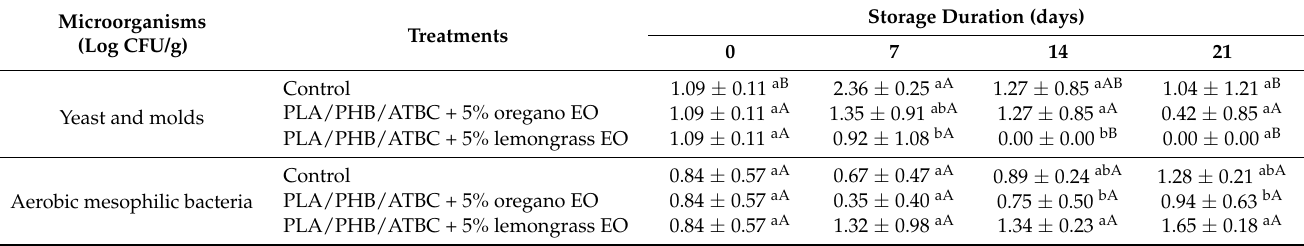
Table 2. Effect of active packaging of strawberry by PLA/PHB/ATBC + 5% oregano EO and PLA/PHB/ATBC + 5% lemongrass EO on yeast and molds and aerobic mesophilic bacteria dur- ing